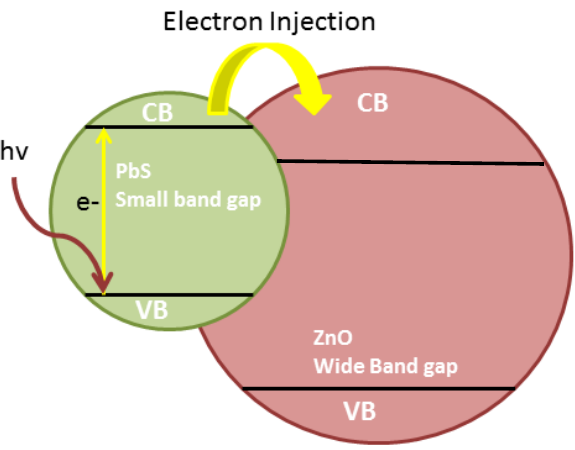
Figure 2. Illustration of the operation of quantum dot-sensitized solar cells, reflecting the charge injection from the absorber (PbS) into electron transport layer (ZnO).